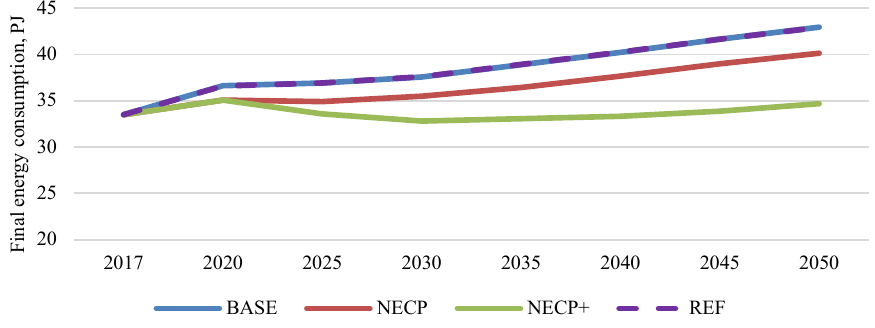
Fig. 6. Final energy consumption in industry sector in the modelled